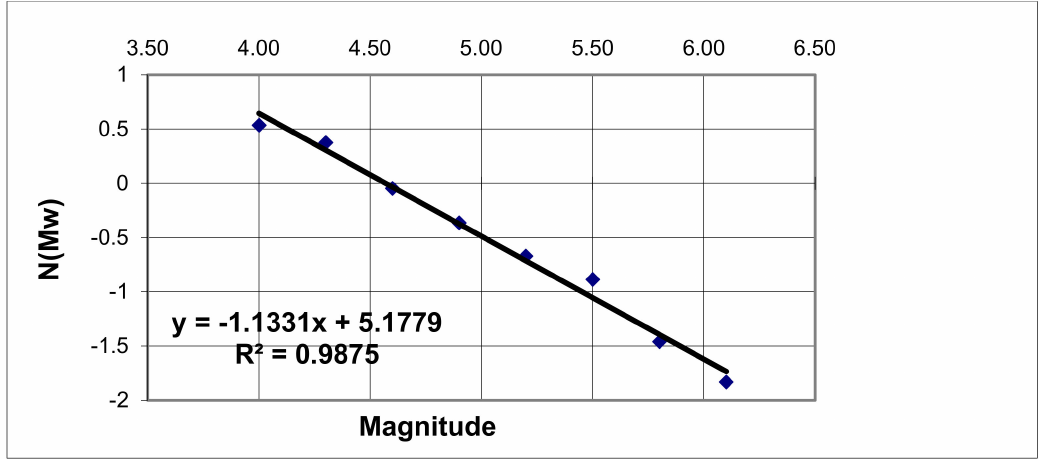
Figure 9. Gutenberg–Richter recurrence relationship curve for source zone 15.